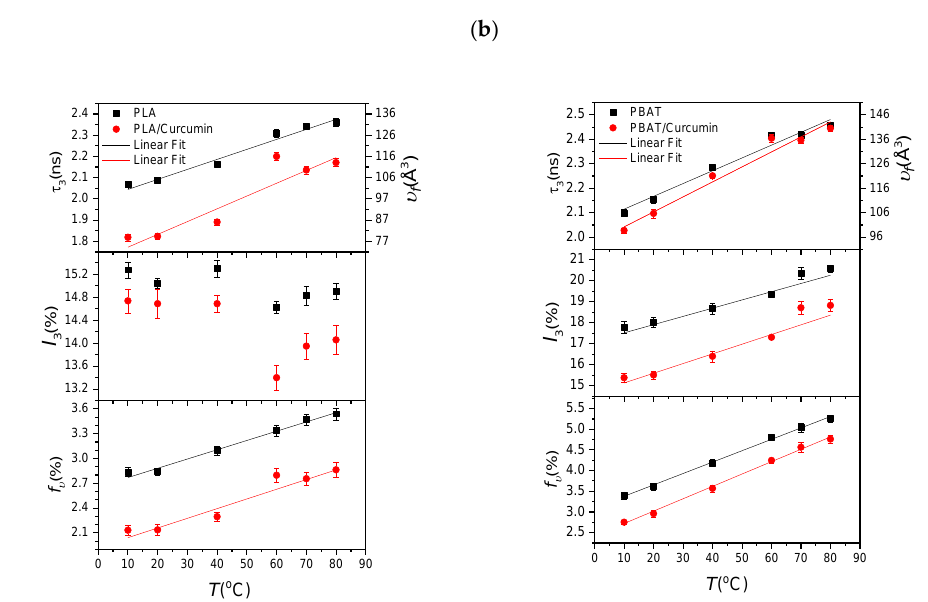
Figure 4. The o-Ps lifetime (with the corresponding free volume hole size on the left axis), intensity, and free volume fraction versus temperature: ( a ) PLA and PLA/curcumin, and ( b ) PBAT and PBAT/curcumin. The solid line is the best fit through the data.